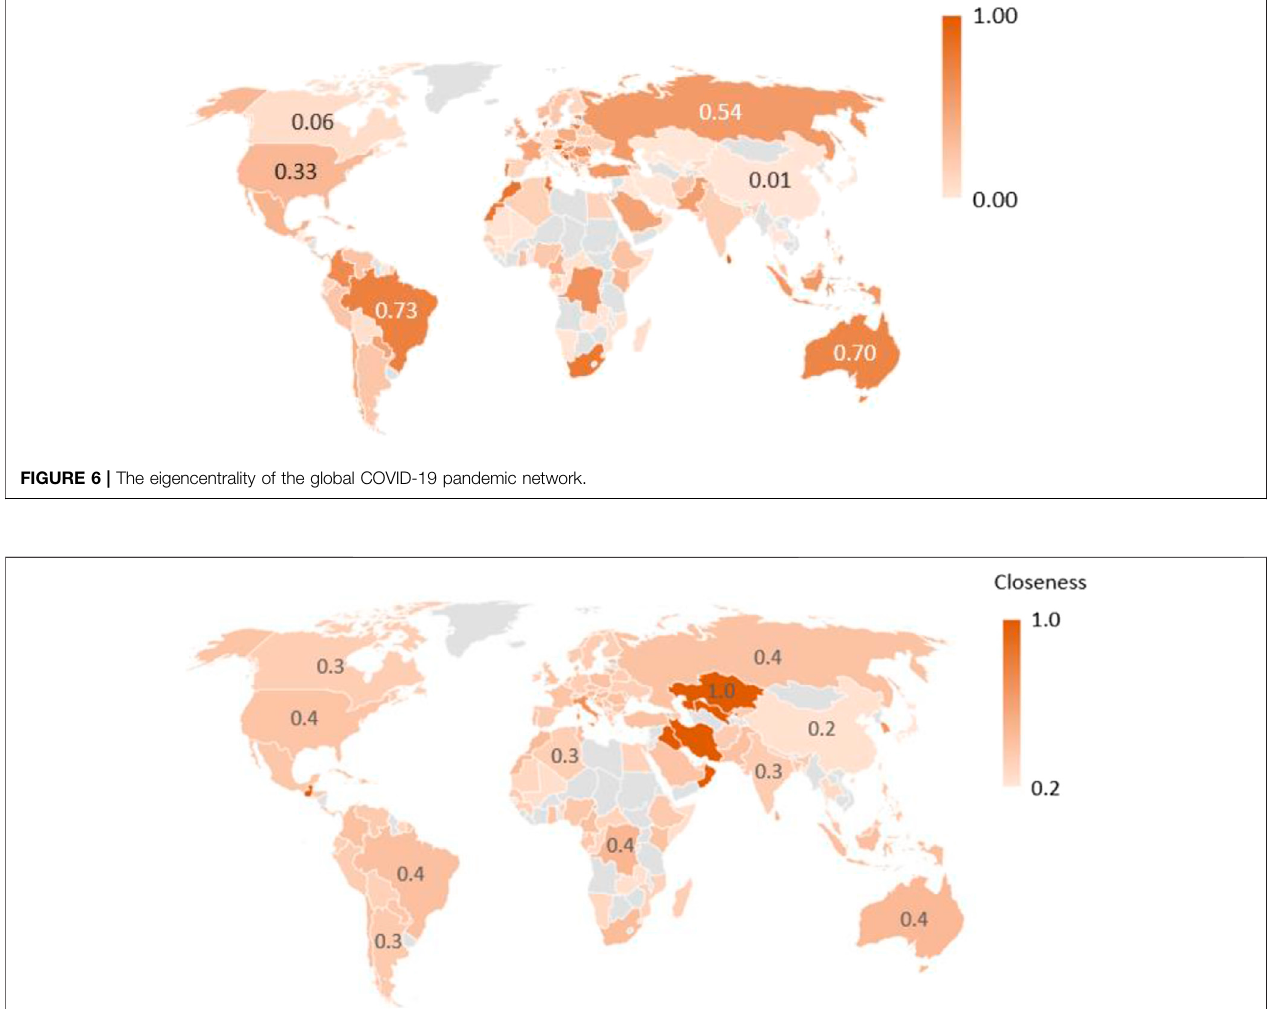
FIGURE 7 | The closeness centrality of the global COVID-19 pandemic network.